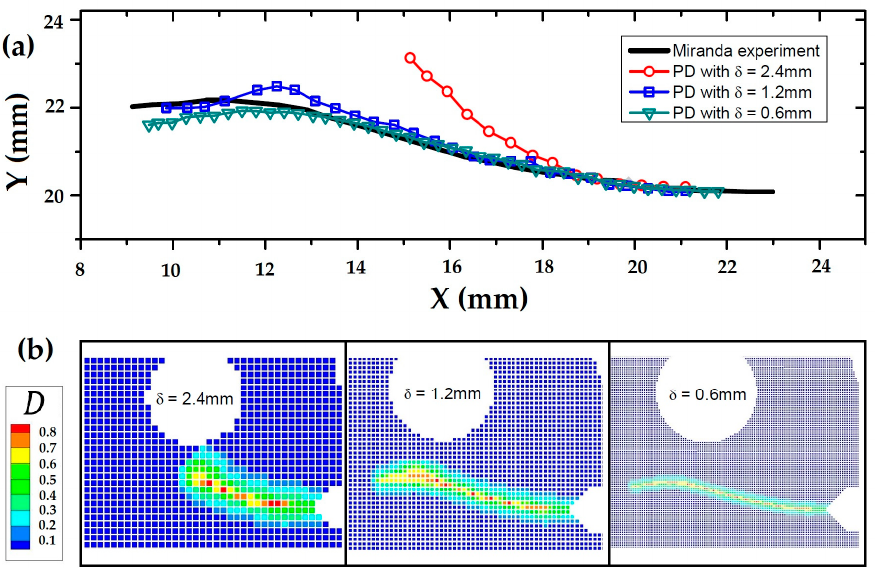
Figure 10. ( a ) PD model and experimental test data for the crack path. ( b ) Different horizon sizes